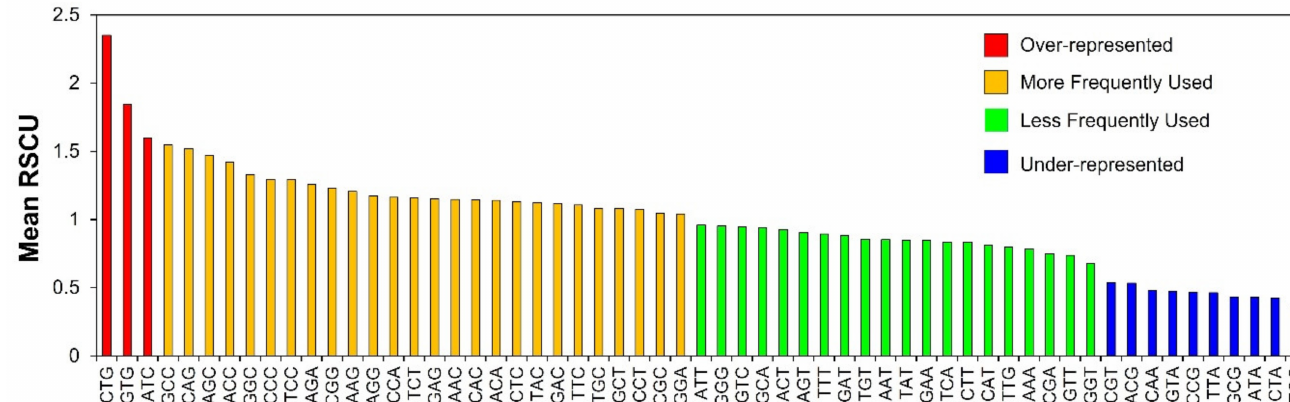
Figure 2. RSCU values for individual synonymous codons of human autophagy genes. The figure depicts the over-represented (RSCU > 1.6), under-represented (RSCU < 0.6), more frequently used (RSCU between 1 and 1.6), and less frequently used (RSCU between 0.6 and 1)